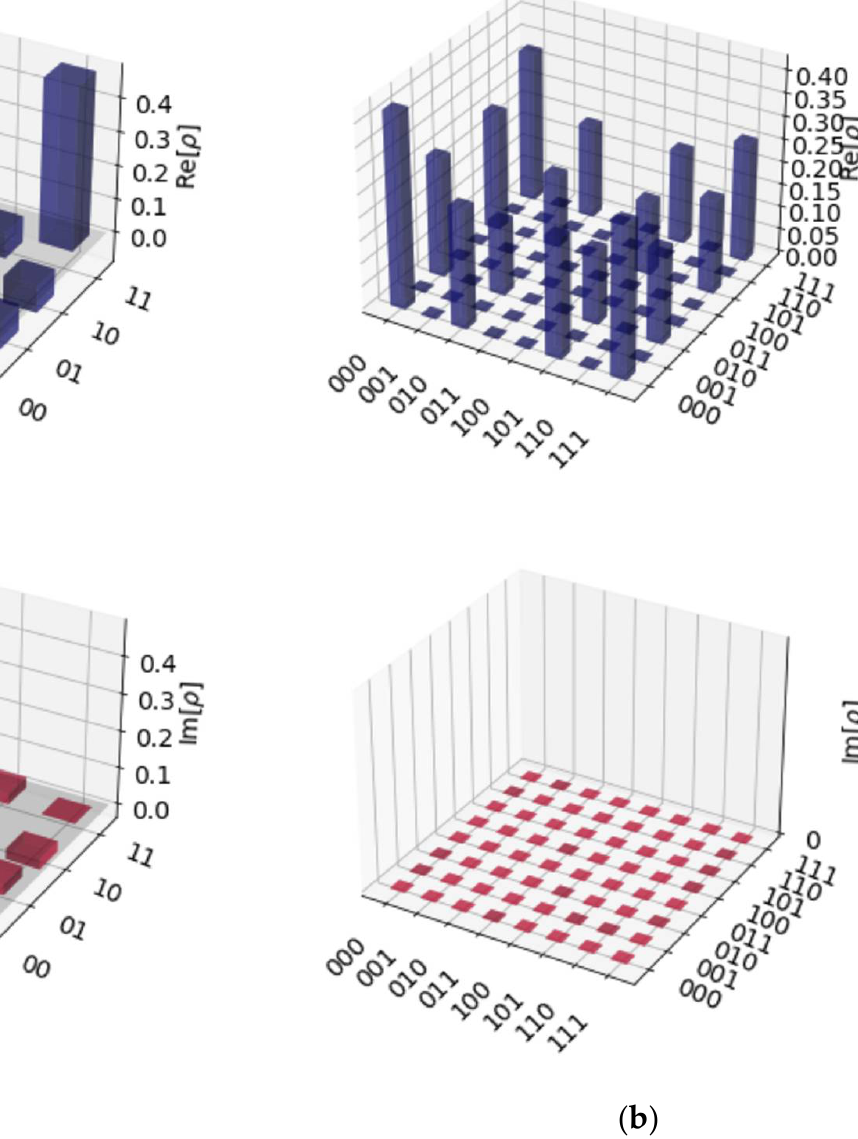
Figure 4. City diagrams for density matrices produced by the learning agent. The best result (highest fidelity) over 10 random seeds and 100 test steps of the policy obtained in the last episode is reported. ( a ) The 2-qubit Bell state experiment. The fidelity is 0.9698. ( b ) The 3-qubit GHZ state experiment. The fidelity is 0.6710.